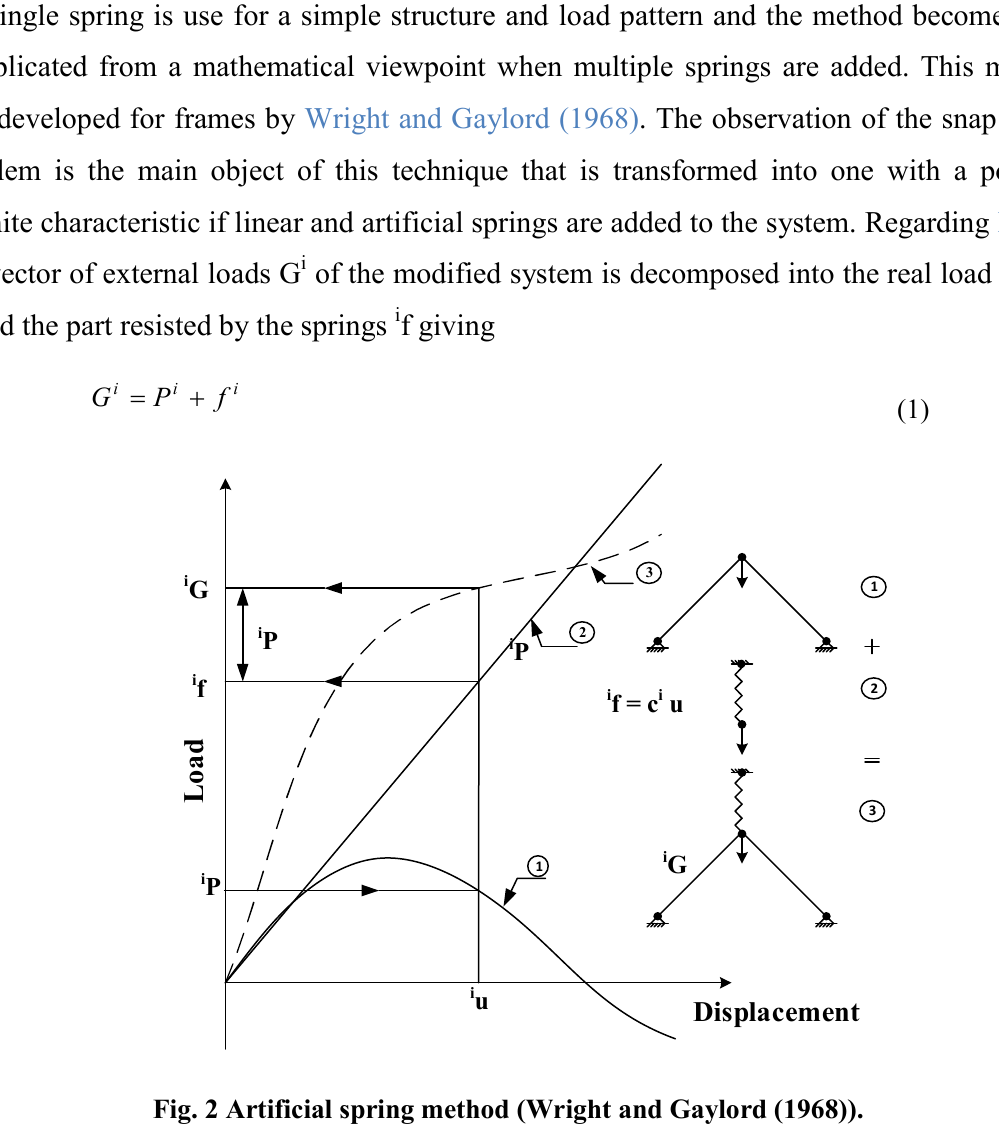
Fig. 2 Artificial spring method (Wright and Gaylord